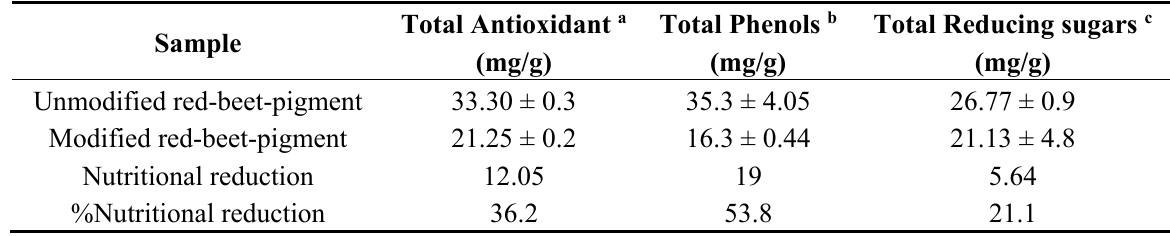
Table 1. Nutritional Value Contents for Unmodified and Modified